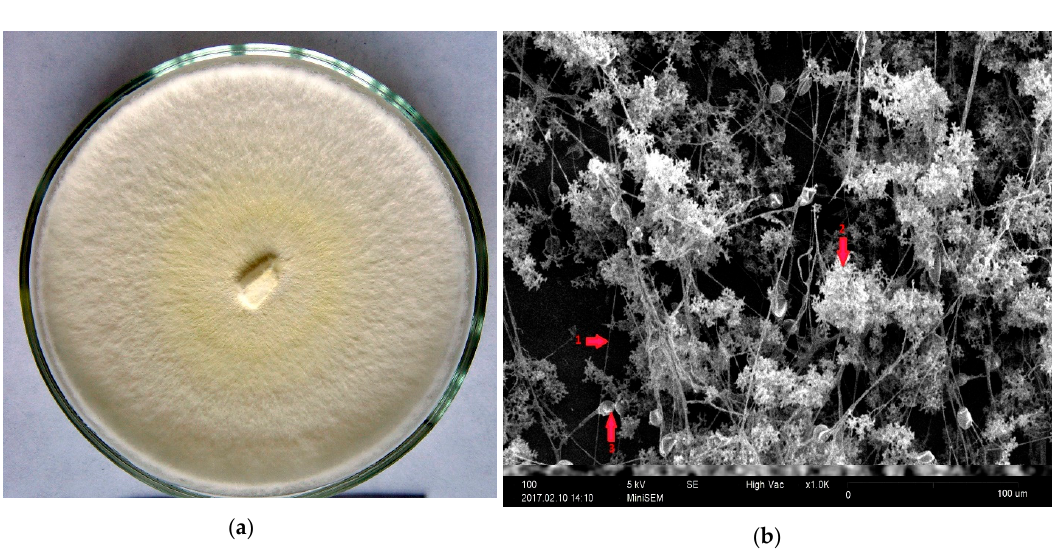
Figure 2. Colonies of G. lucidum ( a ) and SEM image of G. lucidum mycelium ( b ): 1—hypha; 2—coral-shaped mycelium; 3—chlamydospores.